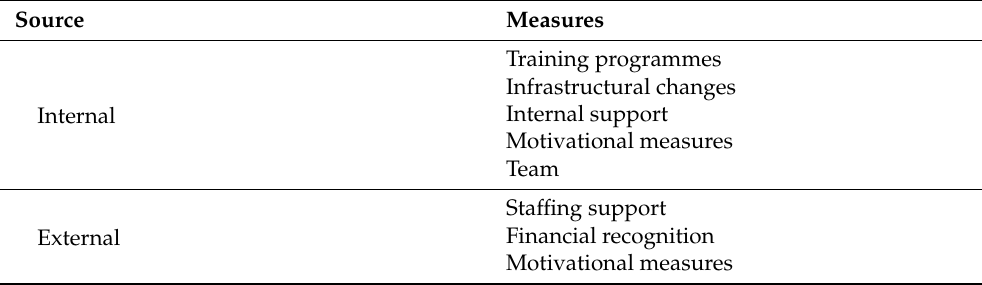
Training programmes Infrastructural changes Internal support Motivational measures Team Staffing support Financial recognition Motivational